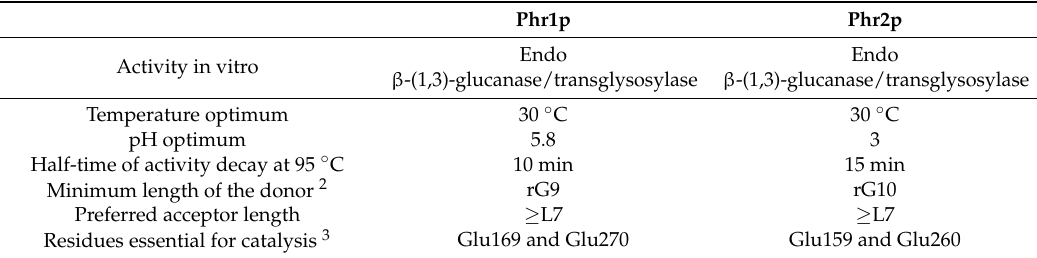
Table 1. Catalytic properties of Phr proteins of Candida albicans 1